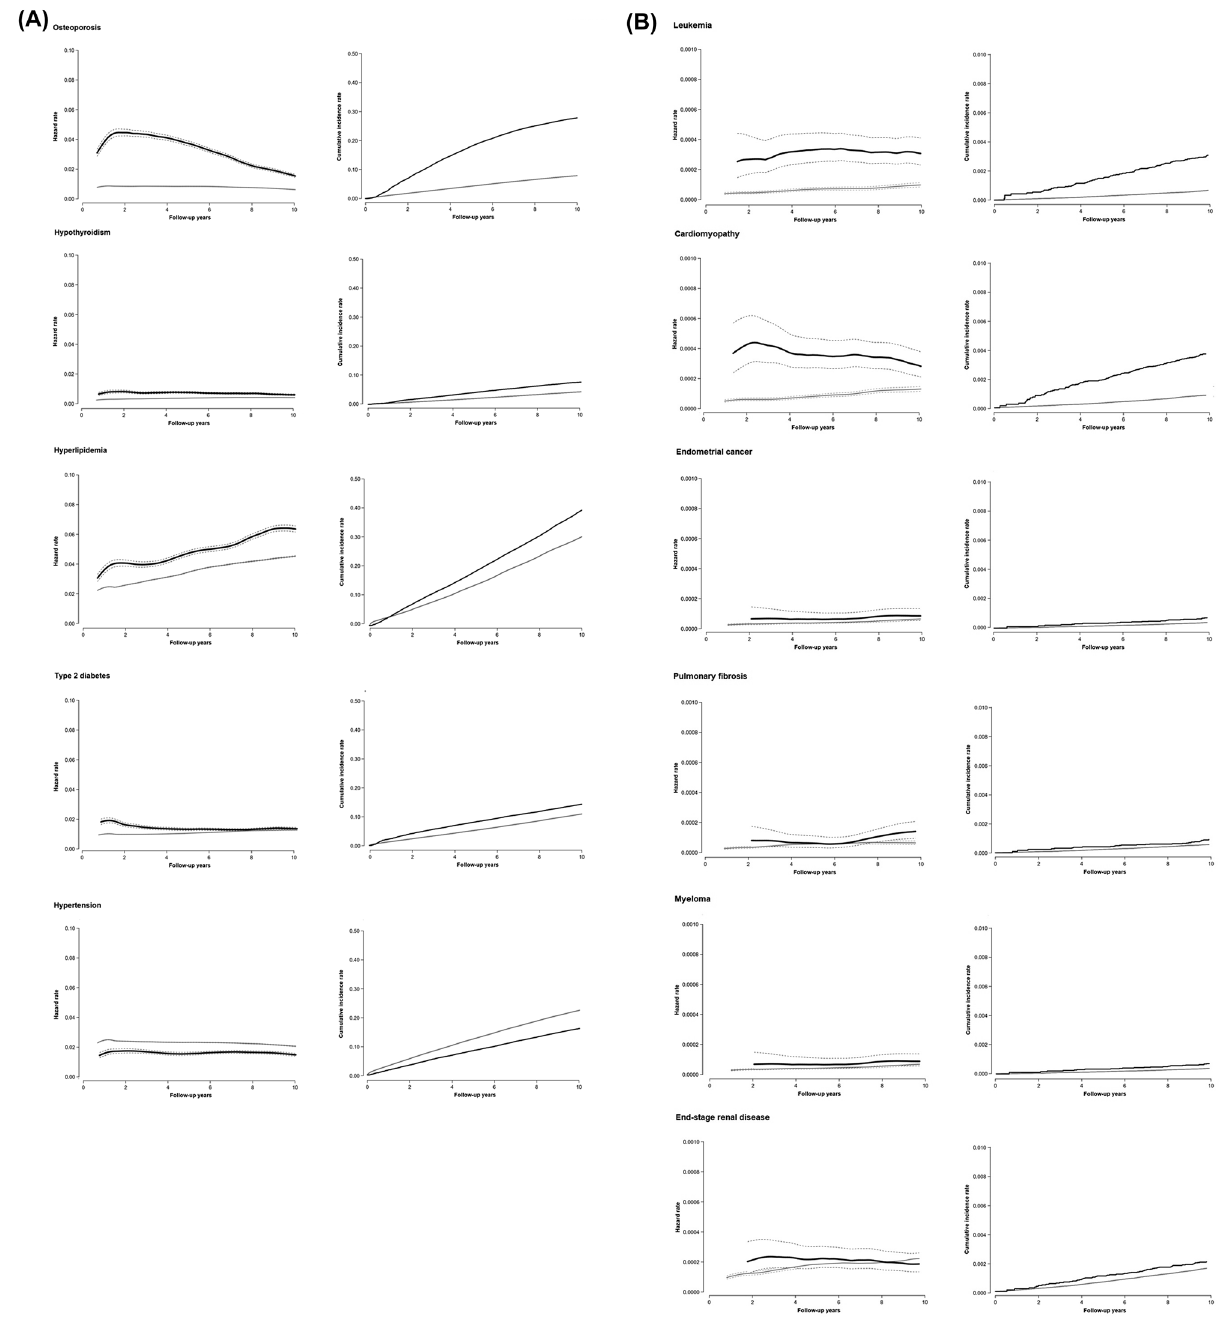
Figure 1. Hazard rate and cumulative incidence of ( A ) common chronic conditions and ( B ) relatively rare chronic conditions by breast cancer status. Hazard rate was calculated using a weighted kernel-density estimate using the estimated hazard contributions. Cumulative incidence was calculated using Kaplan–Meier curves. Participants who developed breast cancer contributed person-time to the exposed group from the time of breast cancer development. Unexposed person-time was contributed by participants who did not develop breast cancer and by participants who developed breast cancer prior to each comorbidity development. To reduce the potential impact of surveillance bias, we considered that outcomes occurring in the first 31 days after a diagnosis of breast cancer corresponded to unexposed